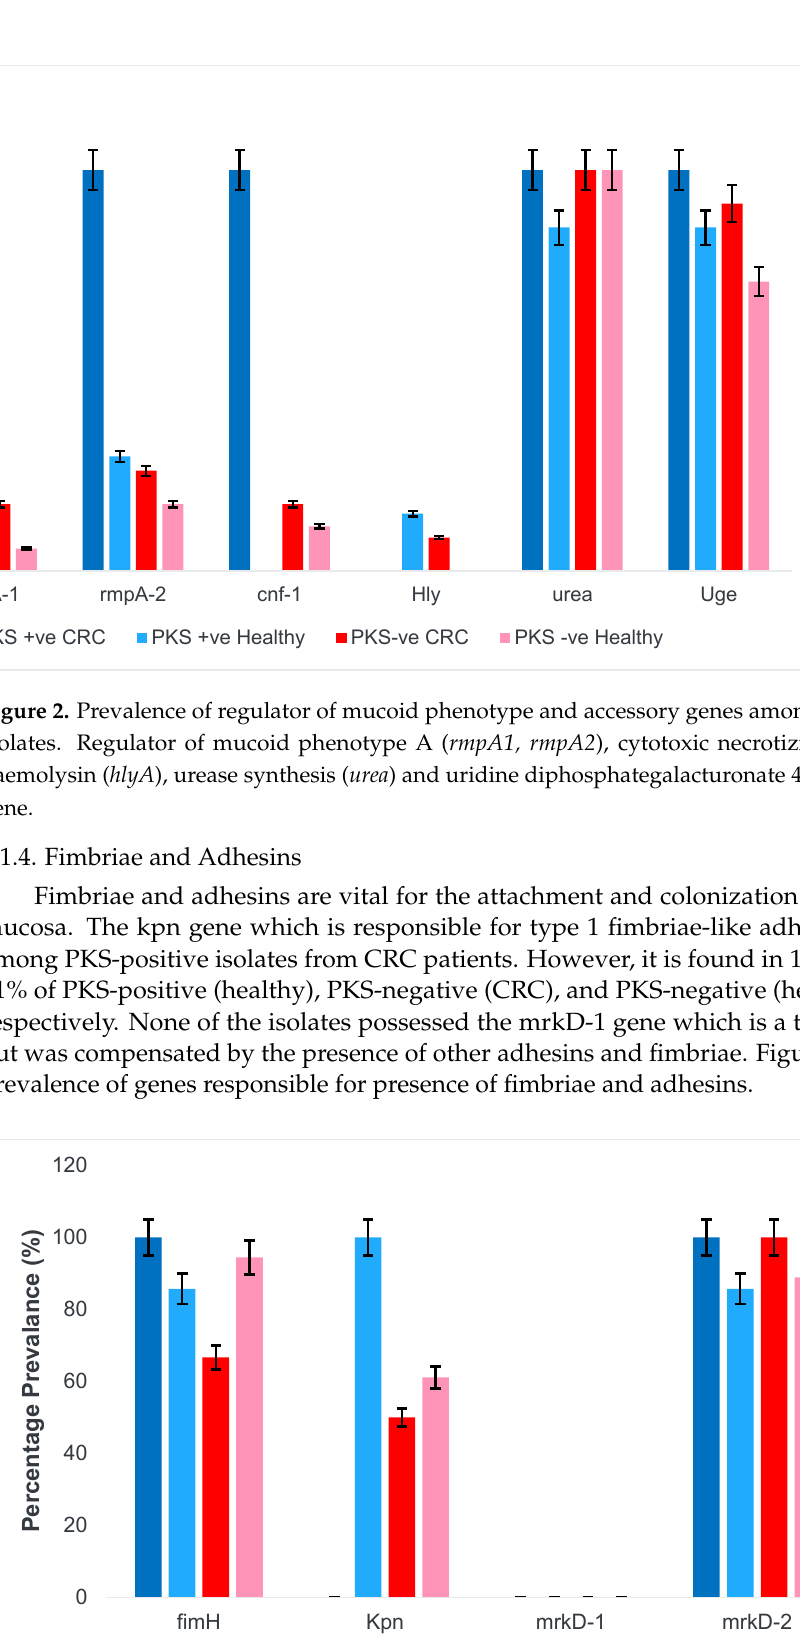
Figure 1 : Presence of siderophores & iron uptake systems among K. pneumoniae isolates. Aerobactin siderophore, Ferric aerobactin receptor ( iutA, iutA1,iucB ), Enterobactin